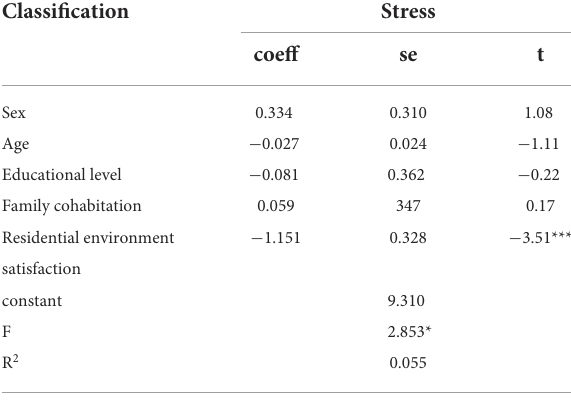
TABLE 5 Relationship among residential environment satisfaction, stress, and depression.